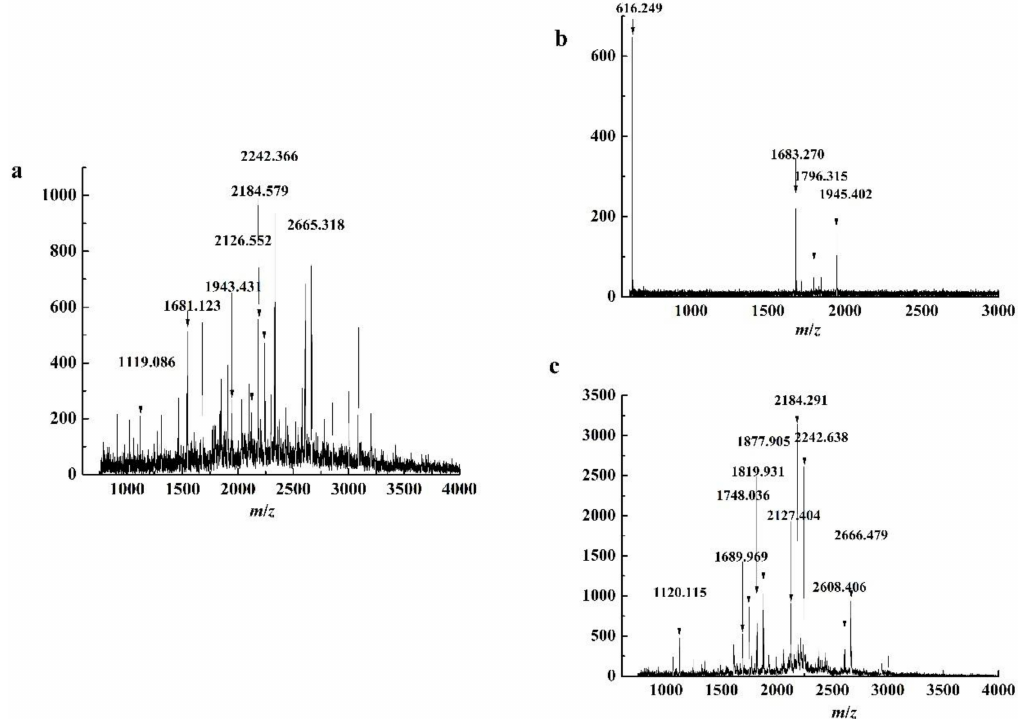
Figure 6. MALDI TOF spectrum of peptides purified of ( a ) WPI hydrolysate, ( b ) top phase and ( c ) bottom phase in